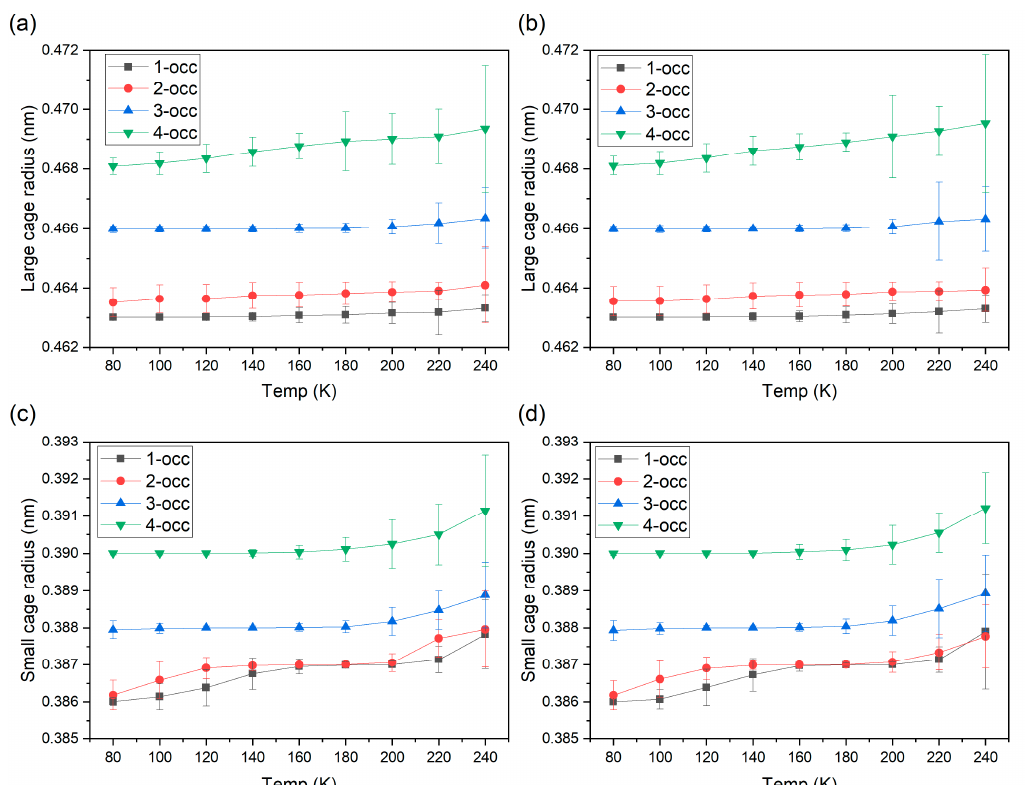
Figure 3. Averaged cage radius with respect to the temperature for ( a ) hydrogen ( b ) deuterium large cage occupancies, and ( c , d ) are for small cage occupancies for hydrogen and deuterium, respectively.